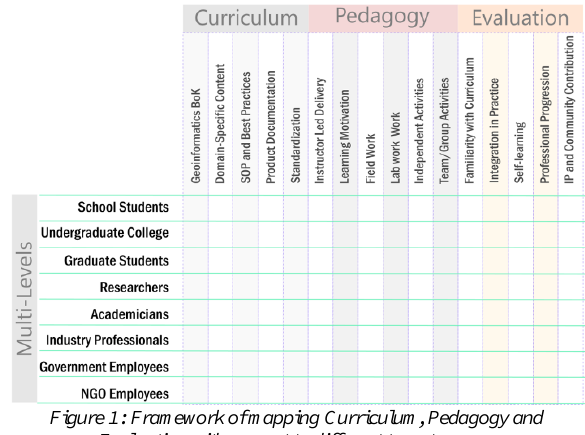
Figure 1: Framework of mapping Curriculum, Pedagogy and Evaluation with respect to different target groups With wide range of practical applicability, data, tools and services in Geospatial technology domain; all three basic pillars must reflect same coverage and agility to maintain relevance.